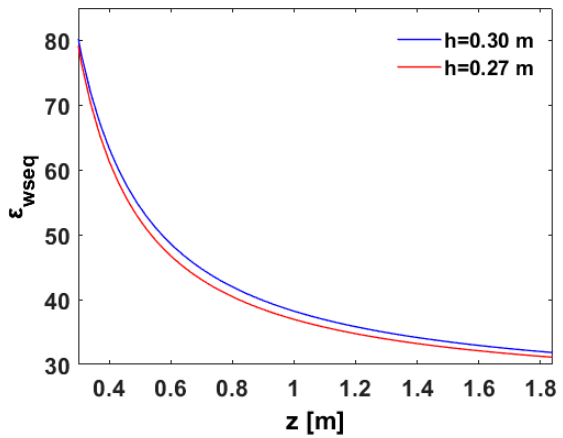
Figure 9. Behavior of the equivalent dielectric permittivity along z -axis for the height h = 0.30 m (blue line) and h = 0.27 m (red line).